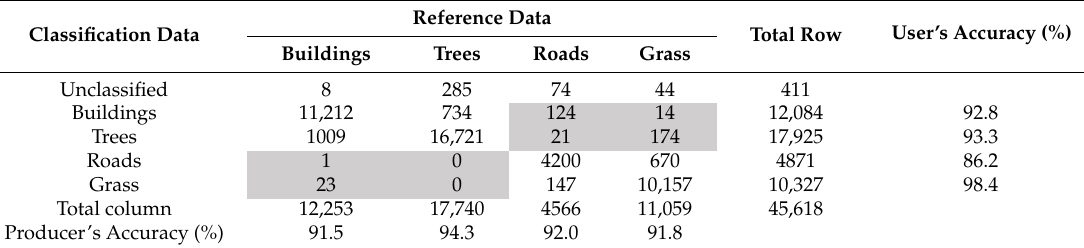
Table 7. Confusion matrix for point classification based on NDVI NIR-G .